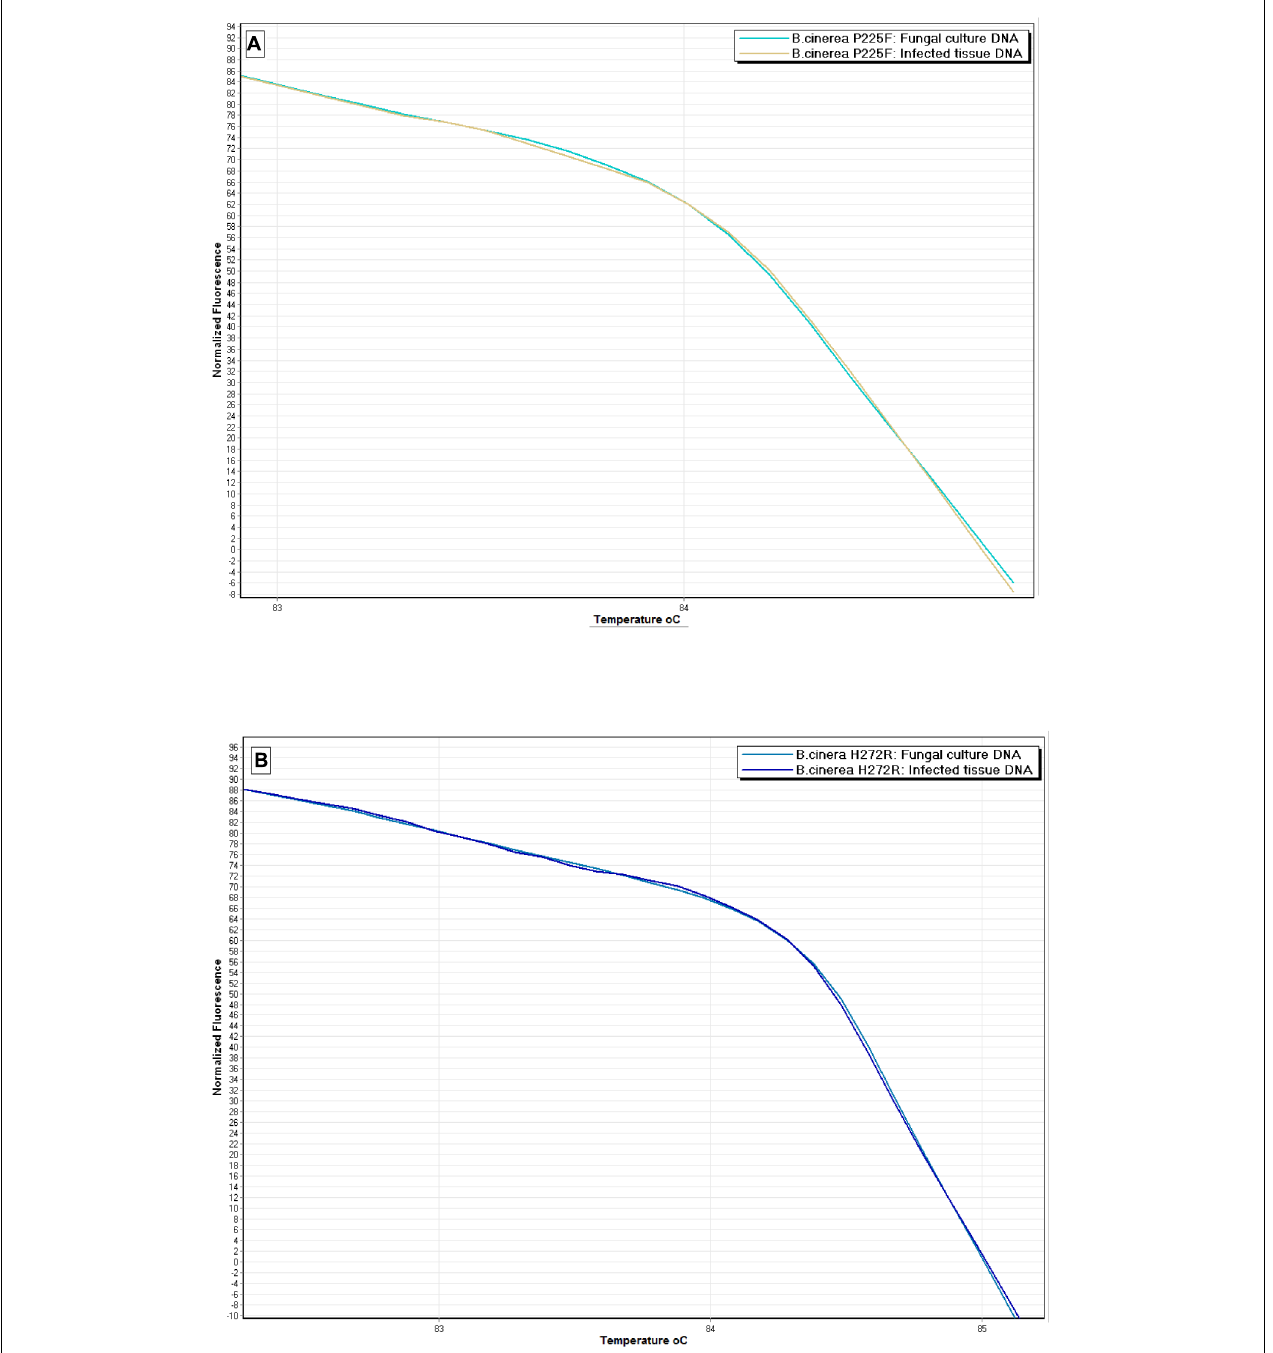
FIGURE 5 | Normalized HRM analysis curves of two B. cinerea isolates possessing P225F (A) and H272R (B) mutations, generated from genomic DNA extracted from a fungal culture and from artificially inoculated strawberry fruit tissue.